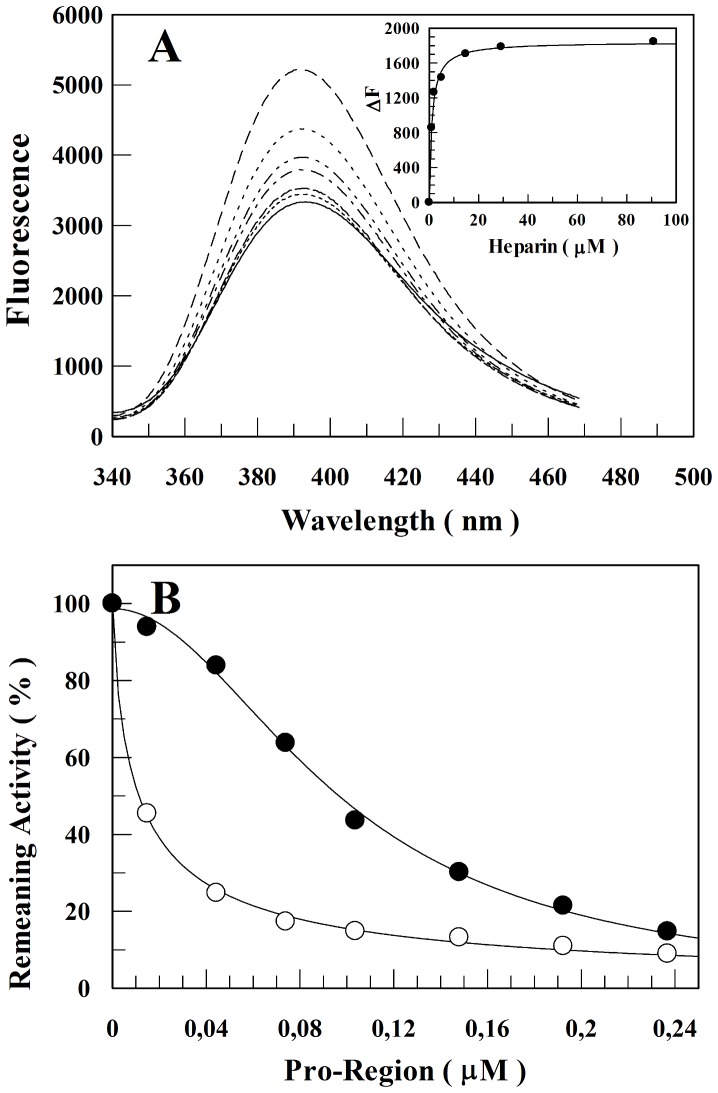
Effects of heparin on the N-terminal pro-region of rCPB2.8.
A, the influence of heparin concentration upon N-terminal pro-region segment intrinsic fluorescence emission. The insert in A shows the variation of the intrinsic fluoresce emission ΔF (F-F0) of the N-terminal pro-region as a function of heparin concentration (0 — 167 µM) as described under “Methods.” B, heparin prevents the inhibitory activity of N-terminal pro-region upon rCPB2.8. The remaining activity of the enzyme was plotted as a function of N-terminal pro-region concentration in the absence (○–○) or in the presence (•–•) of 40 µM heparin.